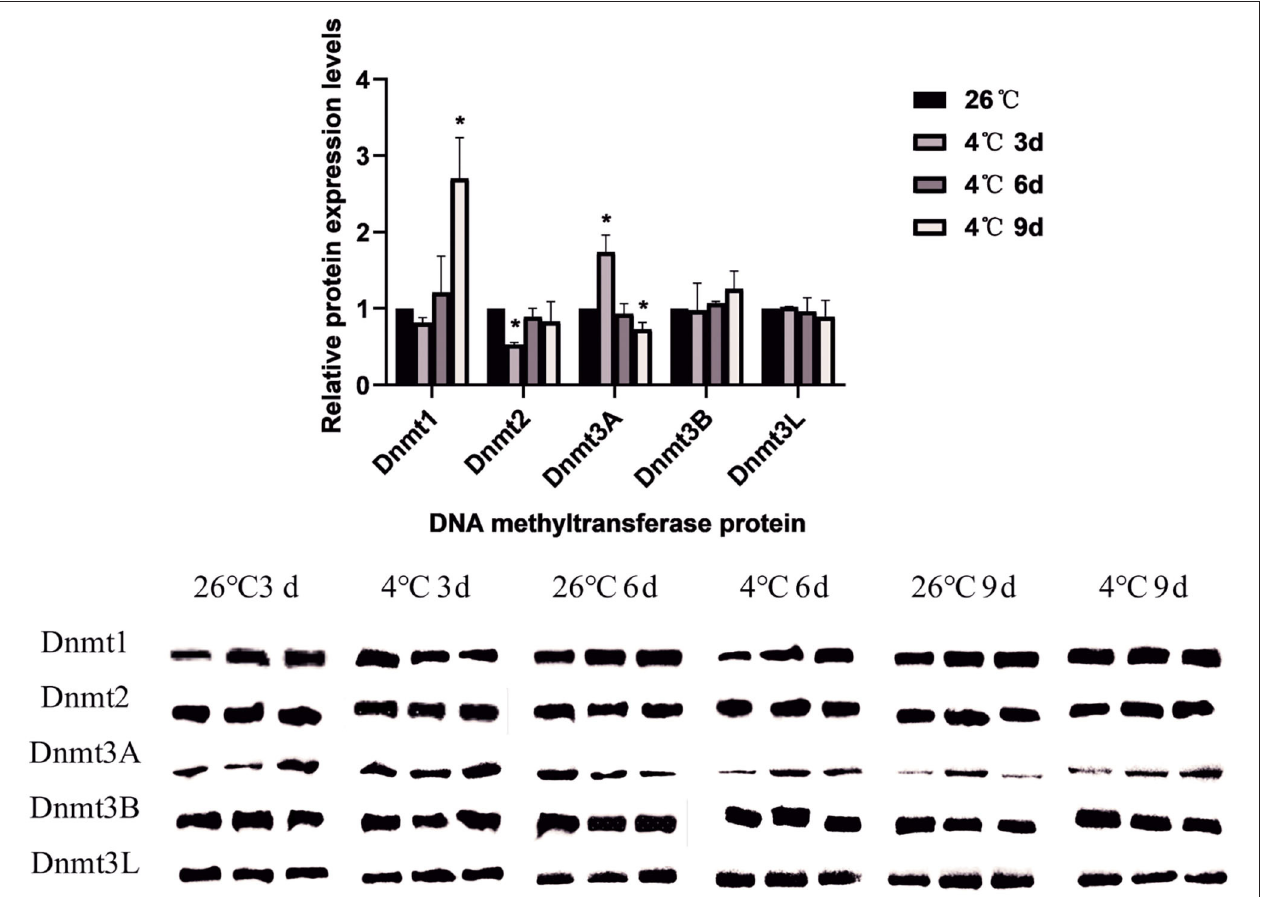
FIGURE 7 | The relative protein expression of Dnmts in D. silvarum after cold treatment. The relative level of the expression of DNA methyltransferase proteins were calculated, and the expression in the control group served as the reference, which was set at 1. The results are expressed as the means ( n = 3) ± SEM. The asterisks above bars indicate a significant difference based on one-way ANOVA followed by Turkey’s test, * P <